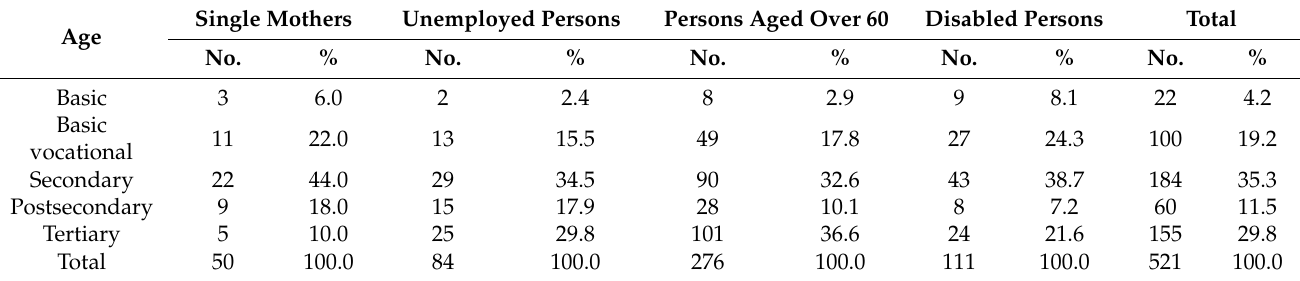
Table 3. Characteristics of the survey population by education and social status ( n = 521).